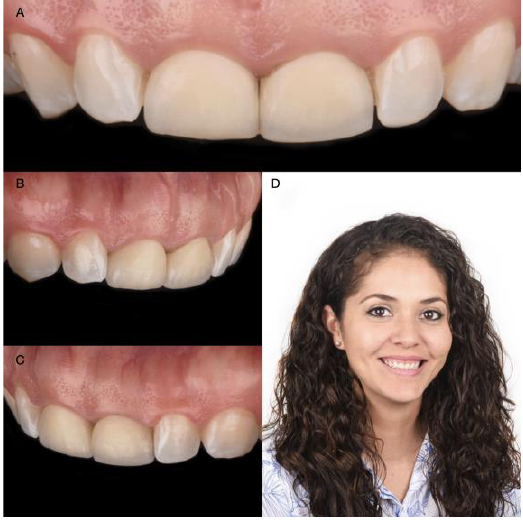
Figure 1. Initial scenario: ( A ) Intraoral frontal view; ( B ) Intraoral right-side view; ( C ) Intraoral left-side view; ( D ) Headshot of face smiling.